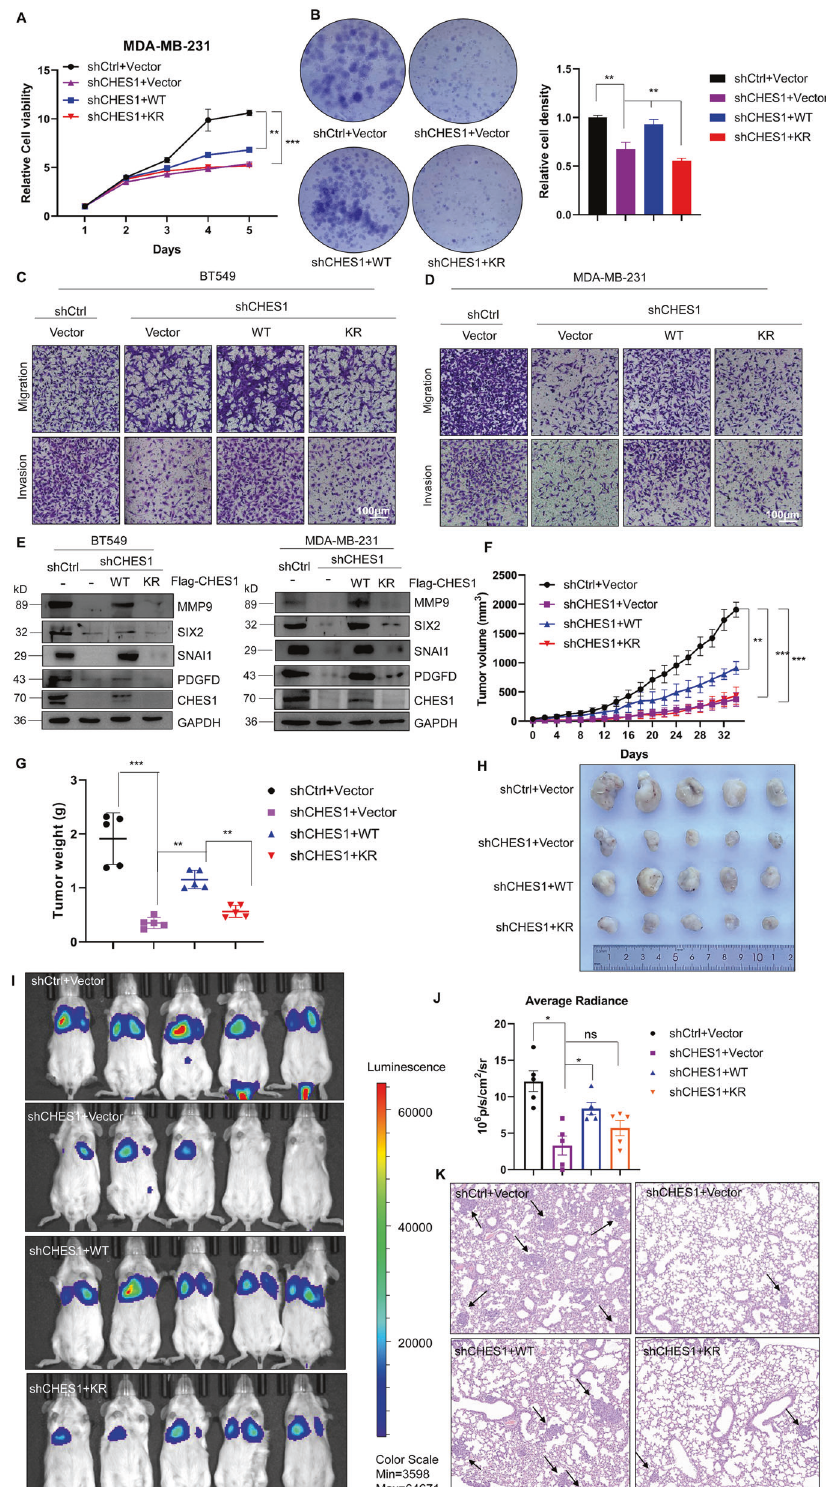
RNA isolation and qPCR Total RNA was extracted using RNAiso Plus (9108, Takara), the procedure was described previously [28]. cDNAs were obtained by reverse transcrip- tion reaction using PrimeScript ™ RT reagent Kit with gDNA Eraser (RR047A, Takara). qPCR assay was conducted to evaluate the relative expression of genes by TB Green ® Premix Ex Taq ™ II (RR82LR, Takara) with Thermal Cycler